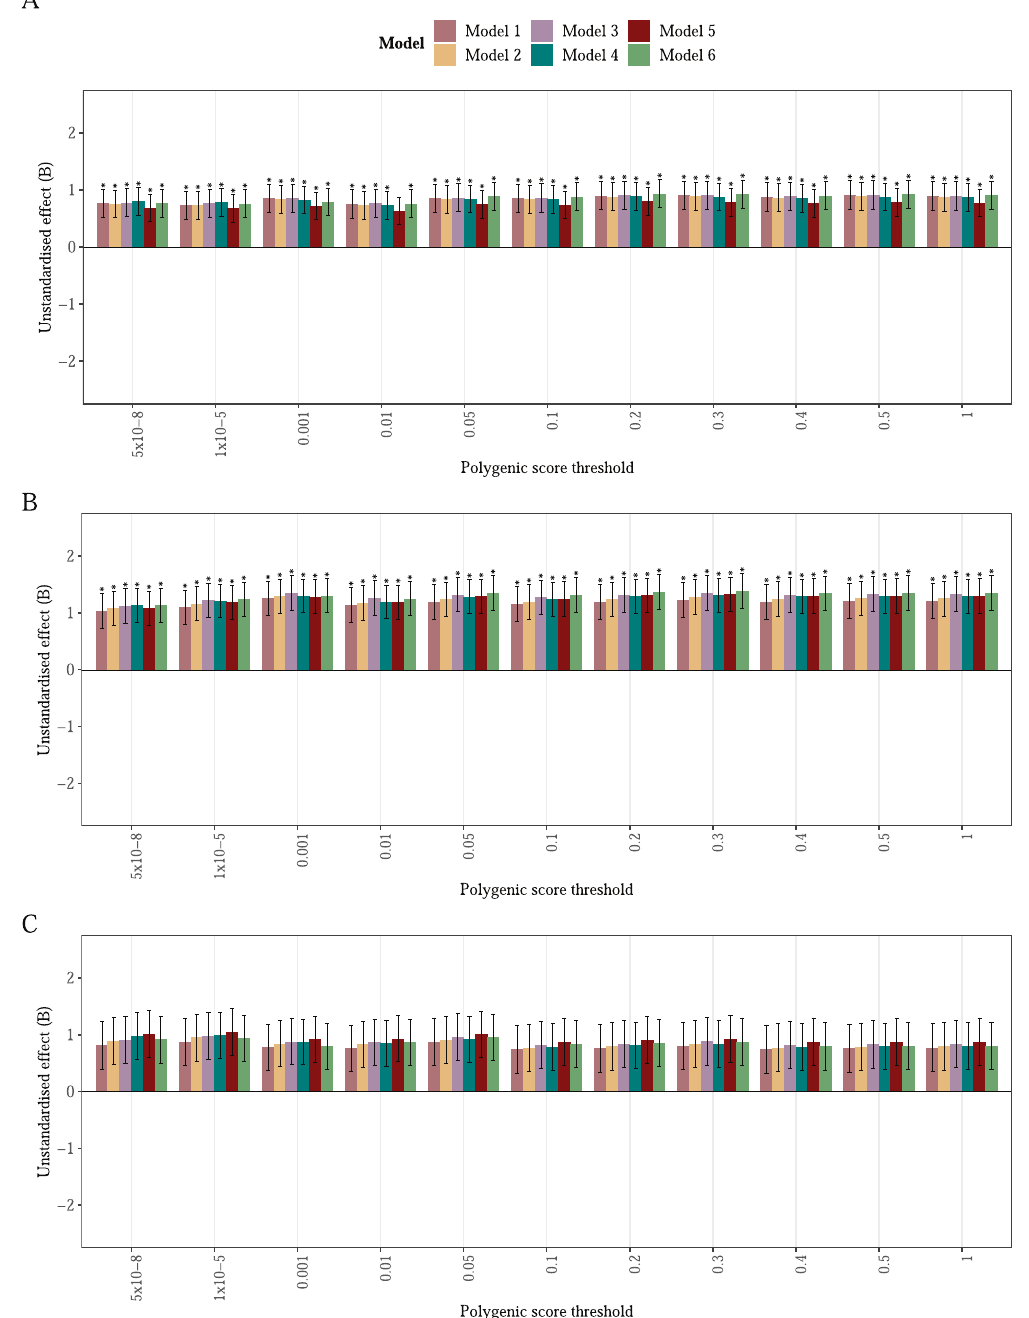
Fig. 3 Body mass index (BMI) polygenic score (PGS) associated with disorder severity measured as Clinical Impairment Assessment (CIA) total score. Bars represent beta estimates ± standard errors. A is based on 2843 individuals with anorexia nervosa and additional eating disorder diagnoses during their lifetime. B is based on 1839 individuals with any clinically ascertained anorexia nervosa diagnosis. C is based on 976 individuals with a clinically ascertained anorexia nervosa restricting subtype. The estimates in model 4 are adjusted for covariates included in the main model: Principal components 1 – 10, treatment region, age, sex, follow-up time and eating disorder diagnosis when including individuals with any eating disorder diagnosis ( n = 2843). The asterisk (*) denotes statistically signi fi cant results ( α =